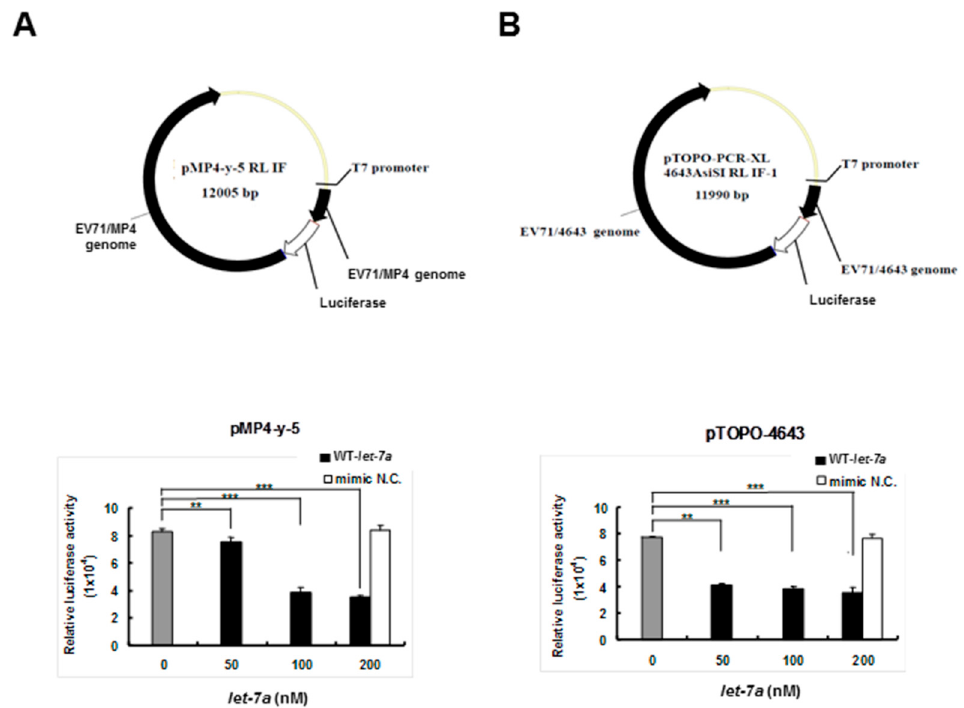
Figure 2. Let-7a suppressed the expression levels of 4643 and MP4 strain-infected EV71 clones in BT7-H cells. BT7-H cells were co-transfected with infectious clone plasmids (pMP4-y-5 and pTOPO-4643) and different concentrations of let-7a by TurboFect TM . Twenty-four hours after transfection, cells were harvested and protein lysate was subjected to the luciferase assay by a dual luciferase reporter assay system. The relative luciferase activity is shown in ( A ) for strain MP4 pMP4-y-5 and ( B ) strain 4643 pTOPO-4643. Mimic NC miRNA: scrambled sequence of let-7a . The relative luciferase activity was normalized with Renilla luciferase. **: p < 0.01, ***: p < 0.001